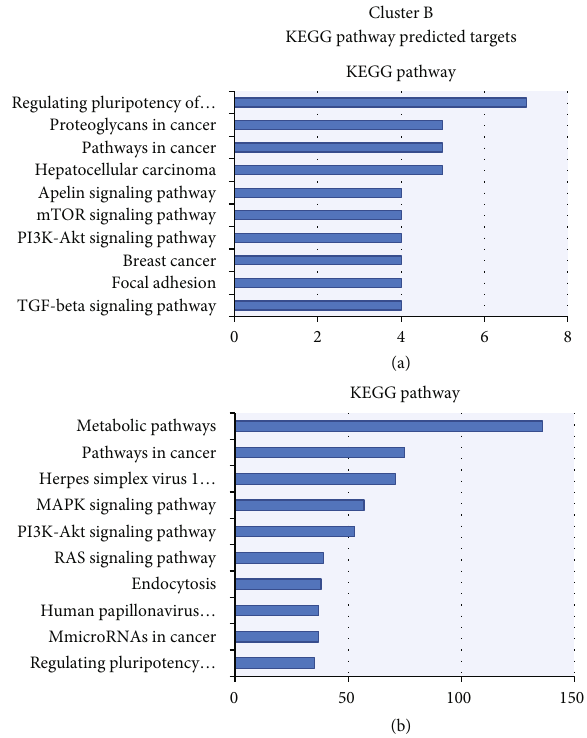
Figure 5: Distribution of enriched KEGG pathways of cluster B: 51 miRNAs deregulated only in the T1D 2-5y group. The chart shows category rankings. The X -axis value represents the number of microRNA ’ s targets in the pathway and the Y -axis the pathways. (a) Represents the potential genes from up-expressed microRNAs. (b) Represents the potential genes from down-expressed microRNAs in comparison with controls. AbP group (individuals without diabetes expressing islet autoantibody), recent T1D group (newly diagnosed T1D patients with duration ≤ 6 months), and T1D 2-5y group (patients with T1D with 2 to 5 years of duration); health control group; Rq: relative expression represented by fold change in comparison to controls; p value: corrected p value. Only target genes identi fi ed by 20% or more of the DEMs with seed of conserved 7-8 mers were submitted to functional enrichment